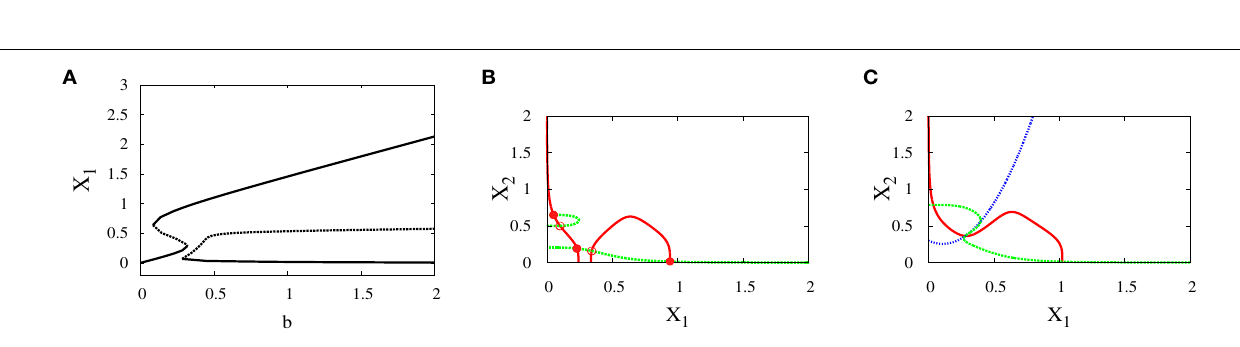
FIGURE 6 |Asymmetric scenario . Supercritical pitchfork bifurcation diagrams. Bifurcation diagram (A) and nullclines at the beginning (B) and end (C) of the bifurcation.The parameters are n = 4, r = 0.5, a 1 = 0.2, a 2 = 0.01, k 1 = 1, k 2 = 1.1.